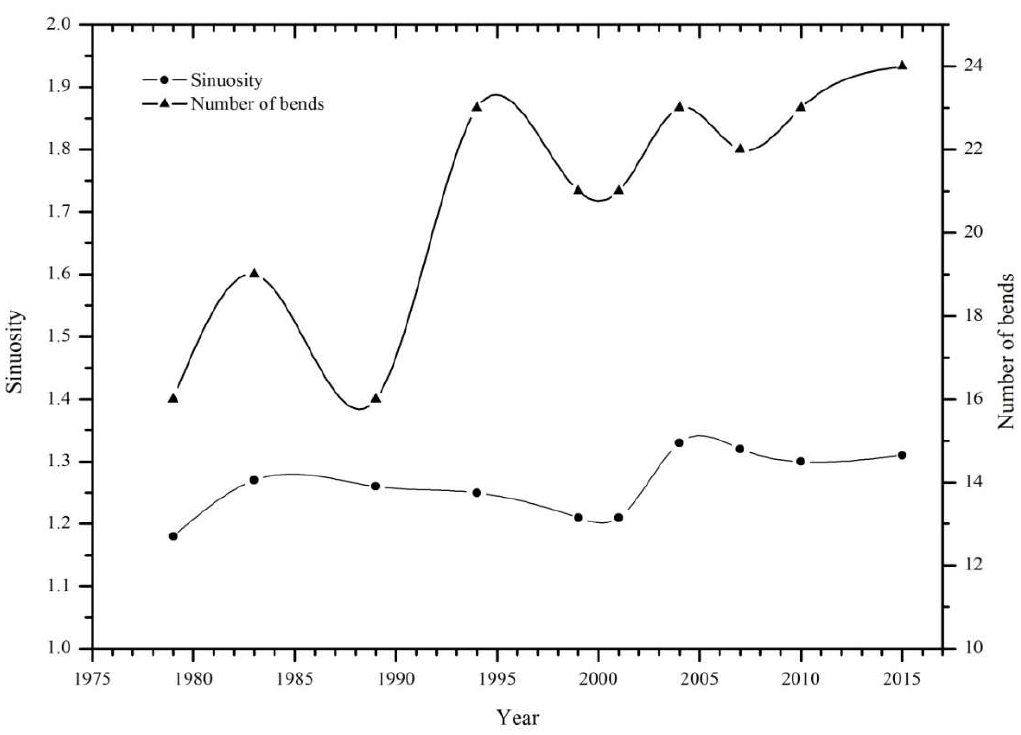
Figure 10. Variations of the sinuosity of the main flow pathways and the number of bends in the study reach from 1979 to 2015.